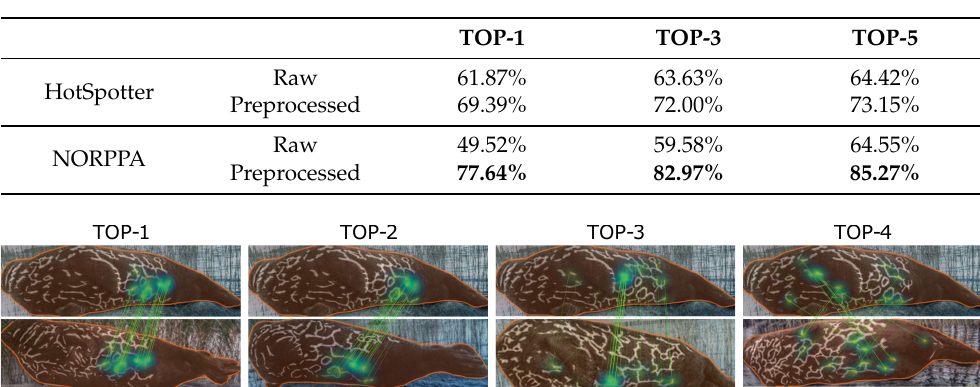
Table 2. Re-identification test set based on top-k accuracy results with HotSpotter and NORPPA. The best results are presented in bold.